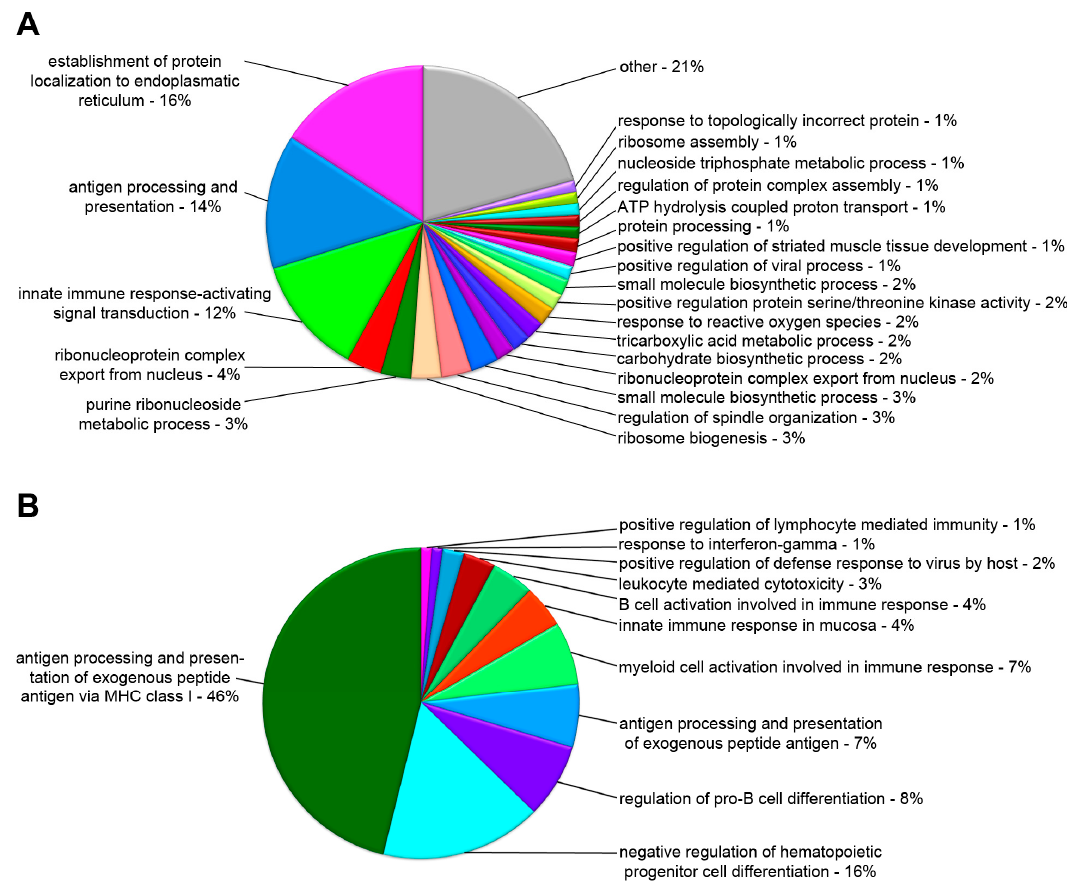
Figure 5. Percentage of significantly enriched Gene Ontology terms for the categories. Biological Process ( A ) and Immune System Process. ( B ) As identified by ClueGO. GO terms with similar functions were merged into groups based on the overlap of the associated genes. Groups were named after the most significantly enriched GO